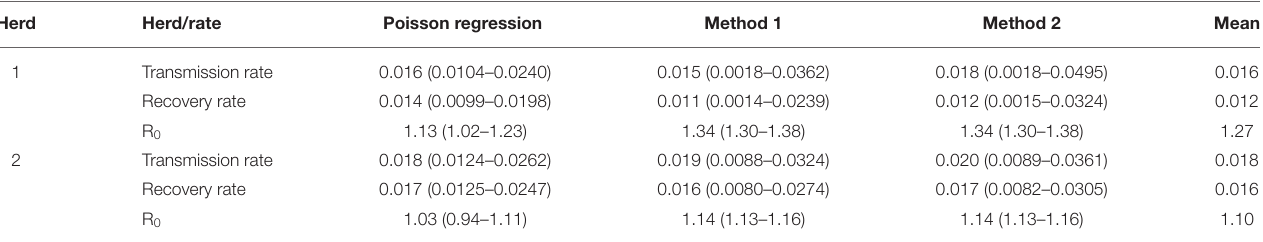
TABLE 2 | Estimated transmission rate, recovery rate and R 0 and 95% confidence intervals for the three methods in each of the study herds. Herd Herd/rate Poisson regression Method 1 Method 2 Mean Transmission